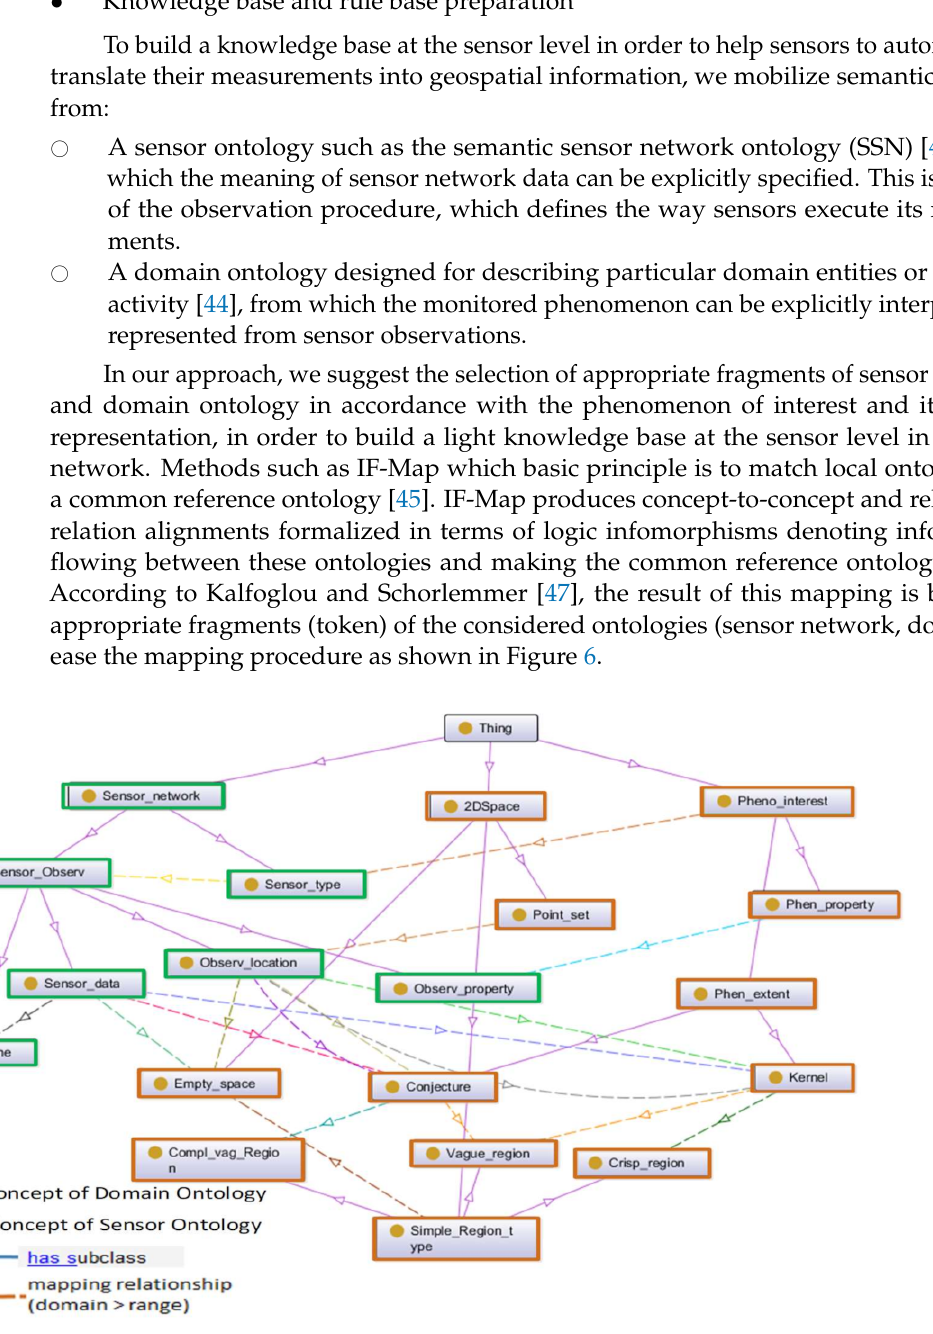
Figure 6. Importing semantic specifications from the domain ontology into the sensor